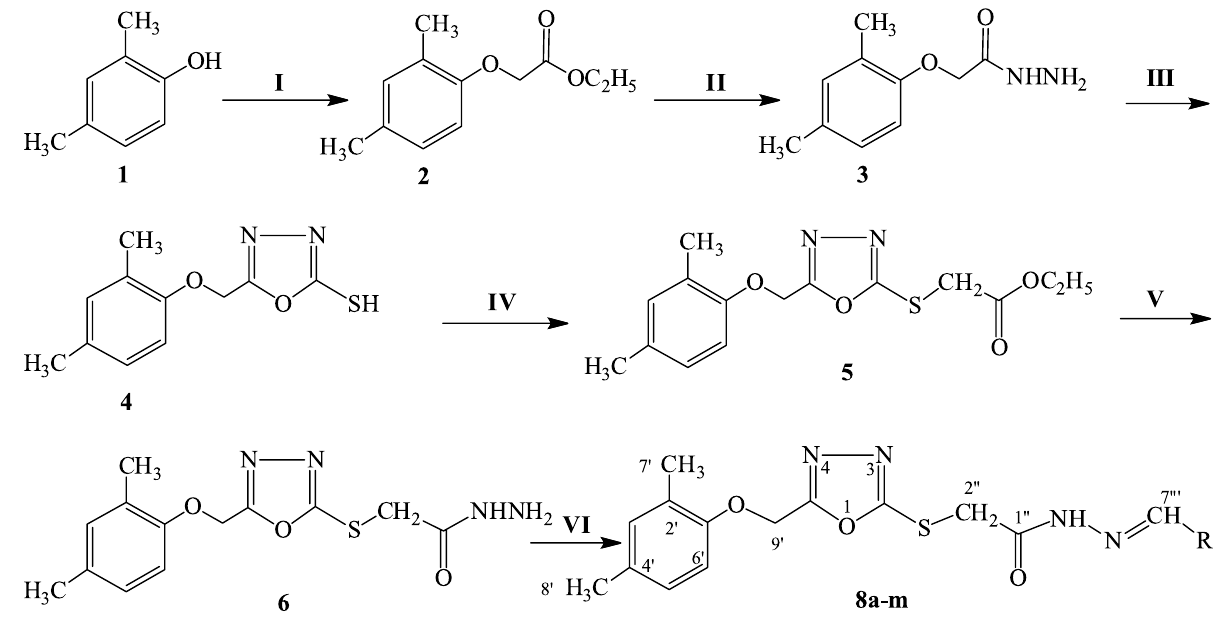
FIGURE 1 - Synthesis of N’- substituted-2-(5-((2,4-dimethylphenoxy)methyl)-1,3,4-oxadiazol-2-ylthio)acetohydrazide ( 8a-m ). Results and Conditions: ( I ) Ethyl 2-bromoacetate (EBA), KOH, EtOH, Reflux, 6 hours ( II ) 80% N hours ( III ) CS , KOH, EtOH, Reflux, 6 hours ( IV ) EBA, NaH, DMF, Stir, 4 hours ( V ) 80% N 2 Aryl carboxaldehydes ( 7a-m ), MeOH, Stir, 2